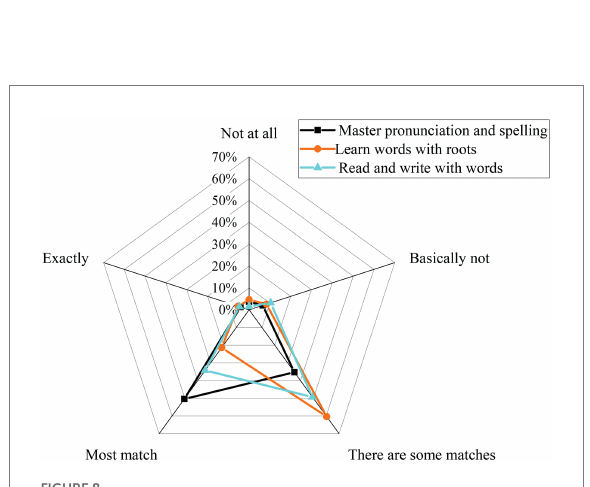
FIGURE 10 The advantages of introducing DL in CET over conventional